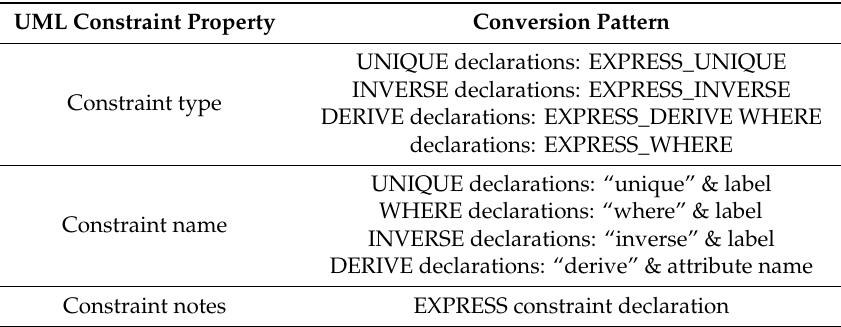
Table 8. Conversion pattern for IFC EXPRESS constraints.